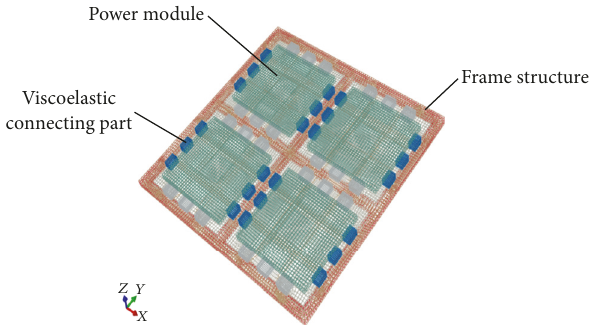
Figure 1: A spacecraft multifunctional structure combining load bearing, vibration reduction, and energy